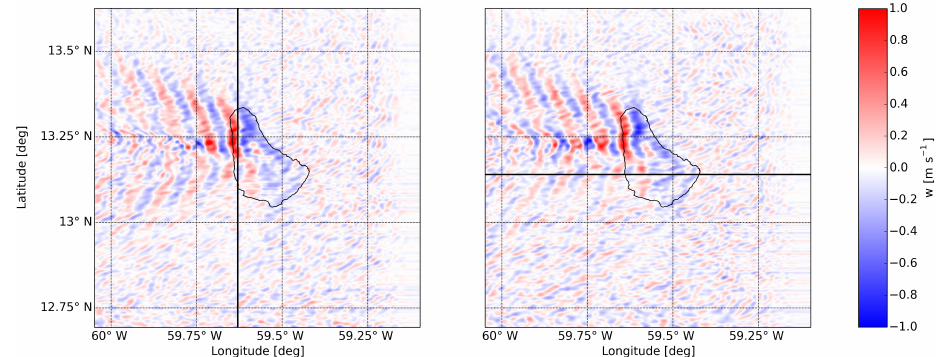
Figure 15. Vertical wind speed at 1975m derived from the LES corresponding to 26 June at 20:00LT (left panel) and 22:00LT (right panel). The flight tracks corresponding to leg 1 (left) and 2 (right) are also indicated (solid, black).